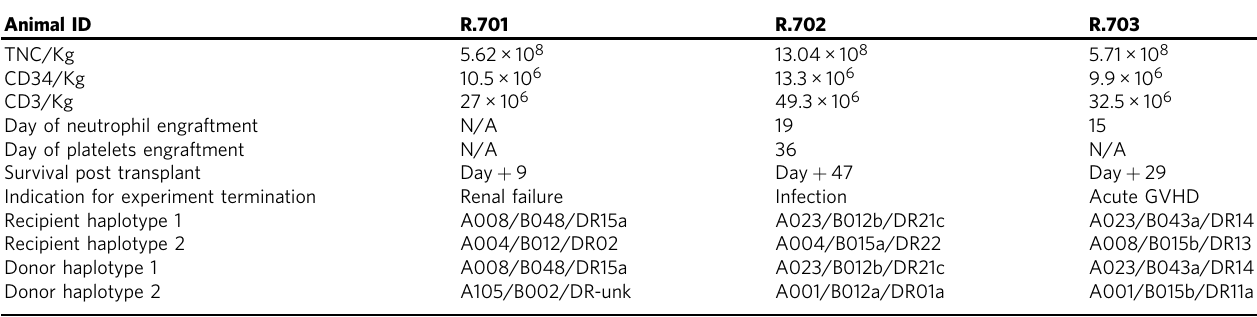
Table 1 Transplant and clinical characteristics Animal